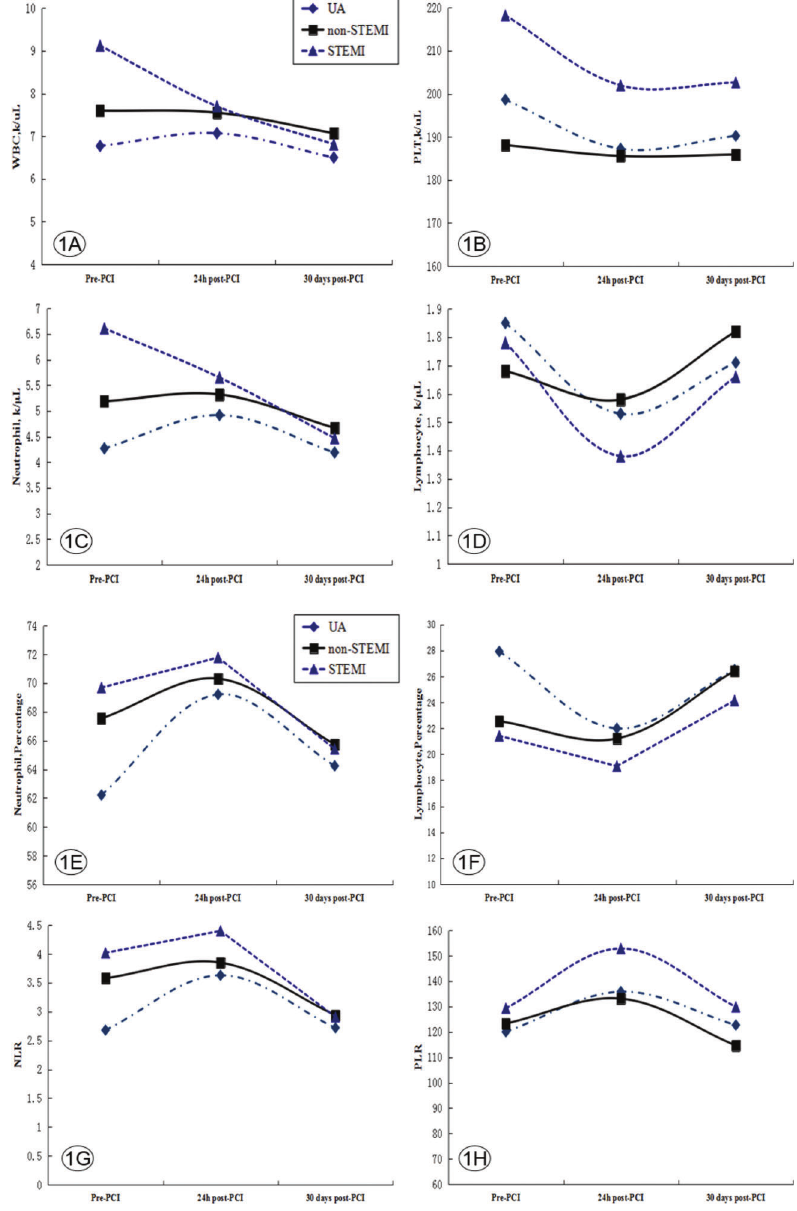
Figure 1 - Changes in the preoperative and postoperative blood cell counts in patients with different types of ACS (n=205). Abbreviations: ACS, acute coronary syndrome; non-STEMI, acute non-ST-segment elevation myocardial infarction; NLR, neutrophil-to- lymphocyte ratio; PLR, platelet-to-lymphocyte ratio; STEMI, acute ST-segment elevation myocardial infarction; UA, unstable angina; WBC, white blood cell count.